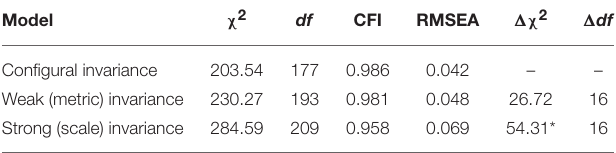
TABLE 1 | Results of invariance testing across